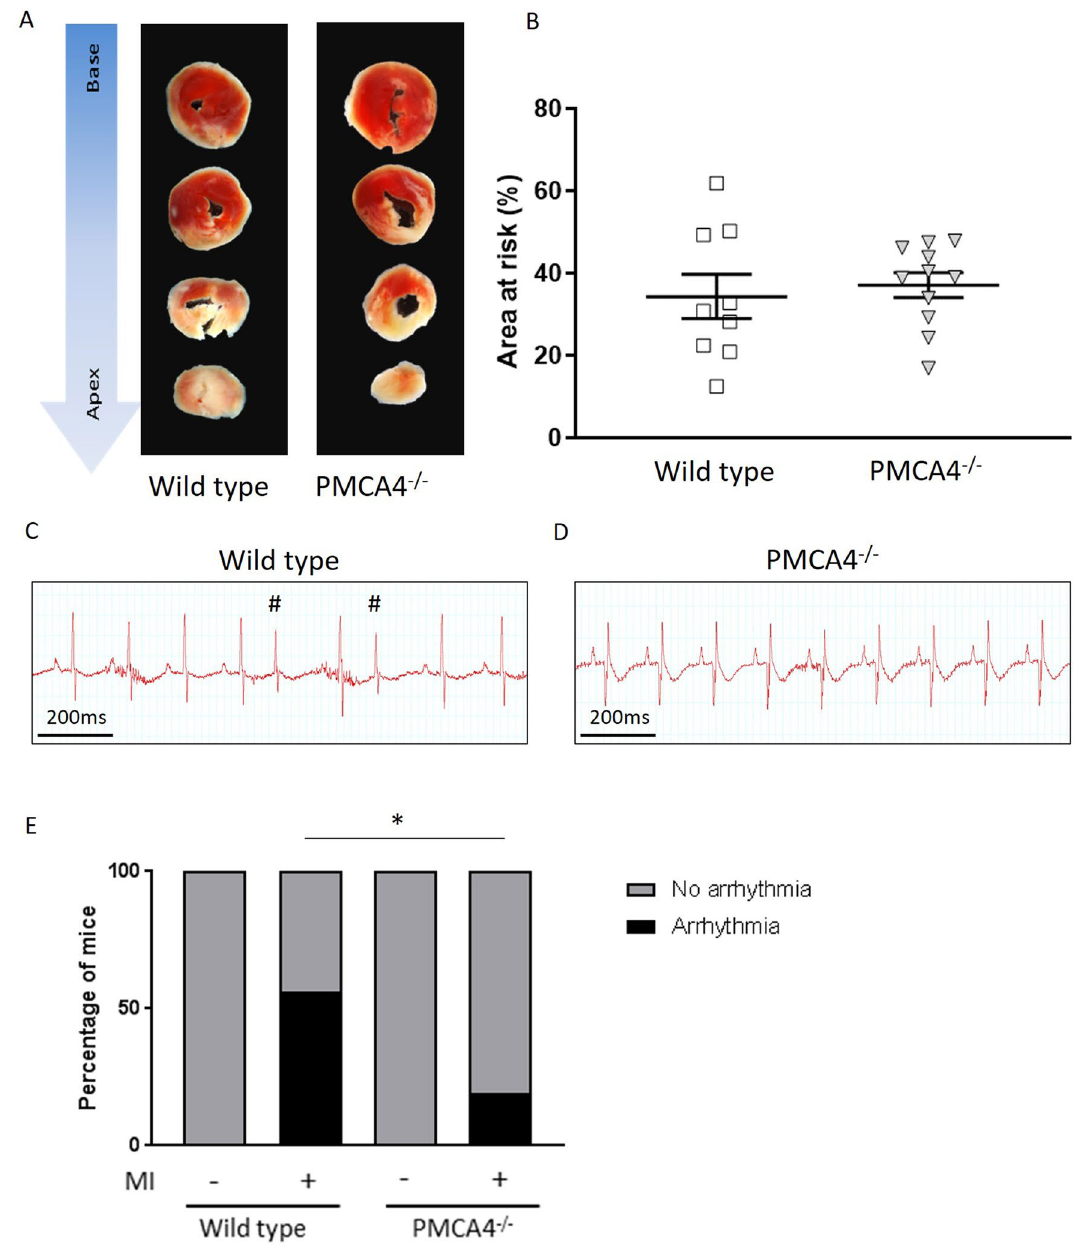
Figure 3. PMCA 4 global deletion may protect against acute arrhythmic events post-MI. ( A ) Representative TTC stained sections from wildtype and PMCA4 −/− hearts 2 days post MI. Images were acquired using a Leica S6D microscope with Leica MC170 HD camera, and Leica application suite EZ software. ( B ) Quantification of area at risk 2 days post-MI. WT n = 9, PMCA4 −/− n = 11. ( C ) Representative 3 lead ECG traces from wild type and ( D ) PMCA4 −/− mice day 1 post-MI. Premature contractions are indicated by #. ( E ) Percentage of mice displaying arrhythmia (black segments) upon ECG examination day 1 post MI. WT sham n = 8, WT MI n = 18, PMCA4 −/− sham n = 8, PMCA4 −/− MI n = 16 * p < rhythm throughout the period of recording. In contrast, 56% of WT MI traces exhibited ectopic beats during the 15 min period, significantly higher than the rate of 19% observed in PMCA4 −/− traces after MI (Fig. 3C–E). Arrhythmic events were higher in both male and female WT mice compared to those with Pmca4 ablation (Sup- plementary Table S2). The premature complexes were narrow and not preceded by visible P waves, suggesting that they were atrial or junctional in origin (Fig. 3C). The rates of prevalence of arrhythmia closely match the overall rate of sudden death for each genotype, and could be associated with improved survival in PMCA4 −/− mice.